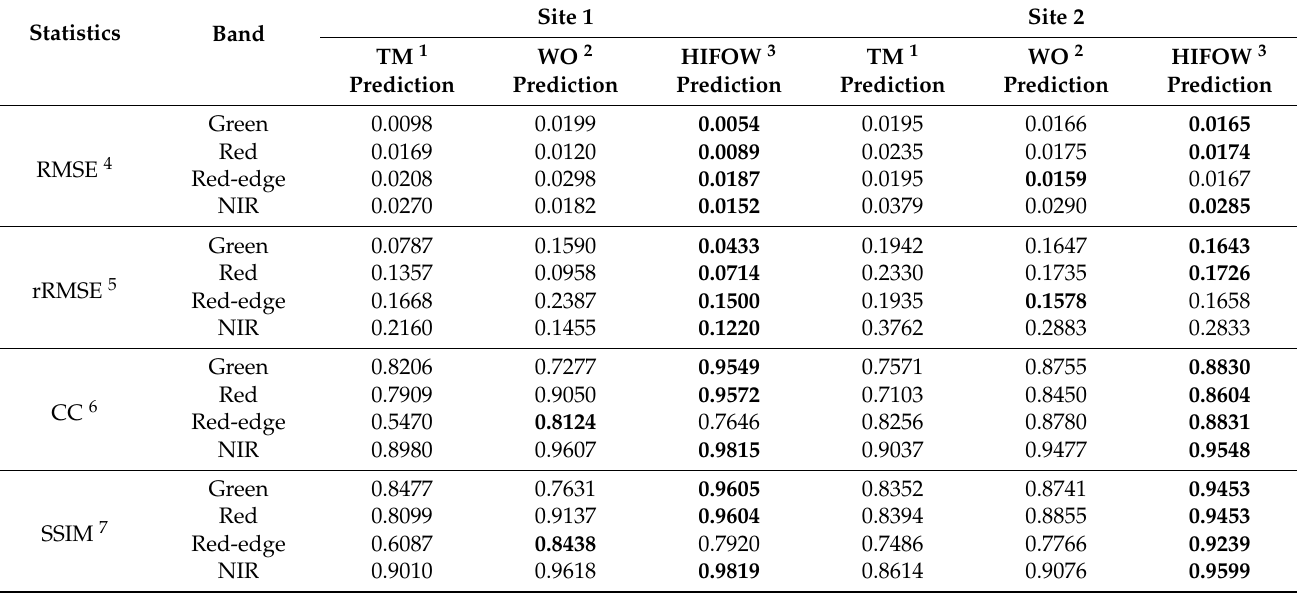
Table 2. Band-wise accuracy statistics of interim prediction results of HIFOW on the two study sites. The best case is shown in bold.